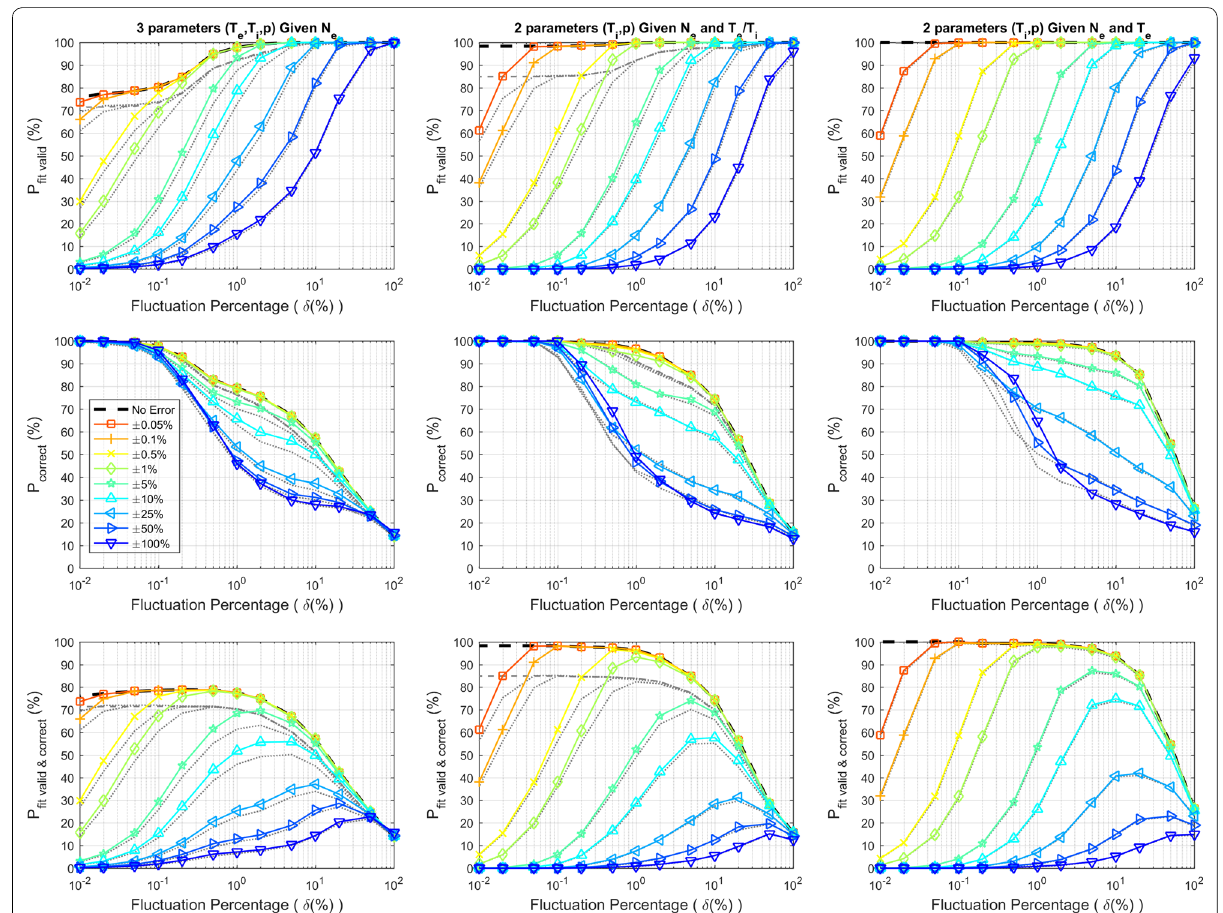
Fig. 10 (Continuous colored lines) probability of convergence ( P fit valid ) and probability of unambiguous estimation ( P correct ) (in percentage) obtained by simulations considering uncertainty on the a priori parameters known from the plasma line: (left) given N e , (middle) given N e and T e / T i , and (right) given N e and T e parameters and at different signal fluctuation percentages ( δ( % ) ). Simulations were done using the PSO algorithm with the parameter configuration “Param. 2”. Probabilities obtained without uncertainty (shown in Fig. 6) are shown with dashed black lines. Results from simulations using the MCLM method (dotted gray lines) are shown for